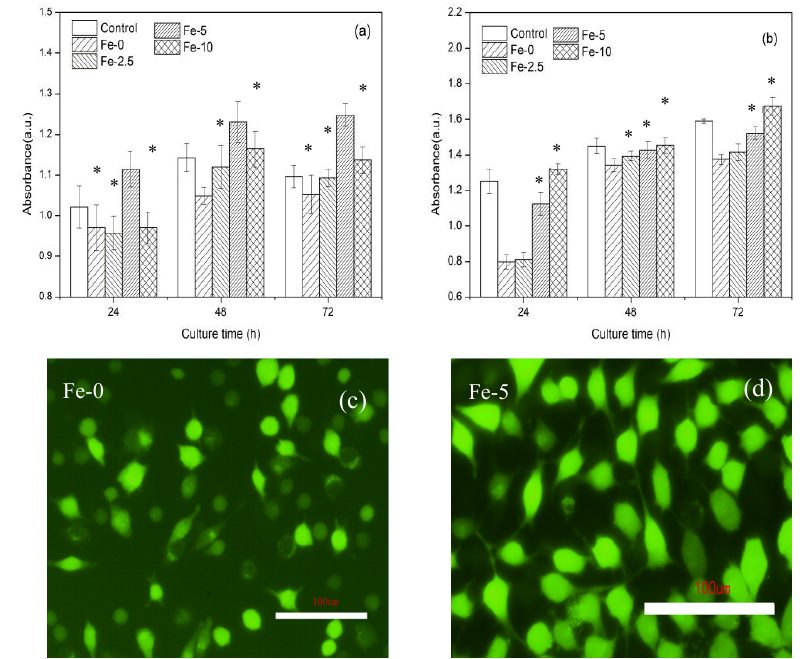
Figure 8. Cell proliferation ( a ) and LDH activity ( b ) after incubation of L929 cells in Fe/C 3 S extract and control (DMEM) for 24, 48 and 72 h and cellular fluorescence pictures ( c , d ) after 72 h of incubation in Fe-0 and Fe-5 extracts. Error bars represent means ± SD for n = 4 (* p < 0.05).